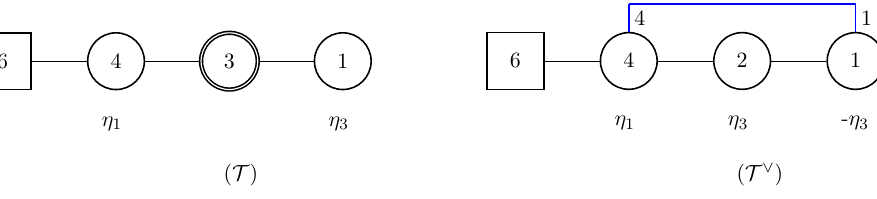
Figure 19 . The two Lagrangians for the 3d SCFT that arise from the circle reduction of the D 4 (SU(6))